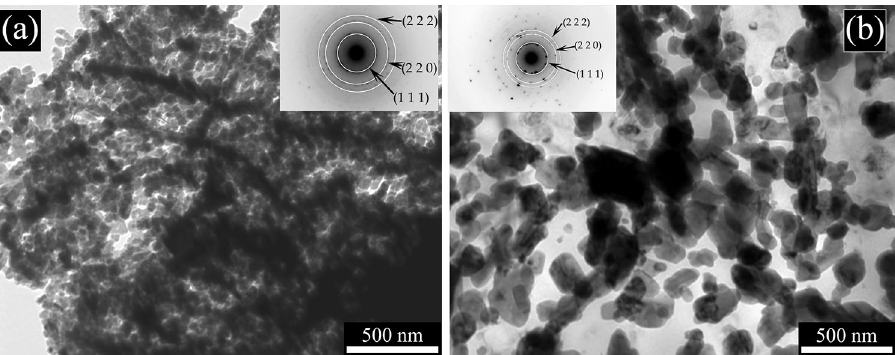
Figure 6. Transmission electron microscope (TEM) images of the as printed sample ( a ) and annealed sample ( b ). Selected area electron diffraction (SAED) pattern is reported in the upper part of the two images.